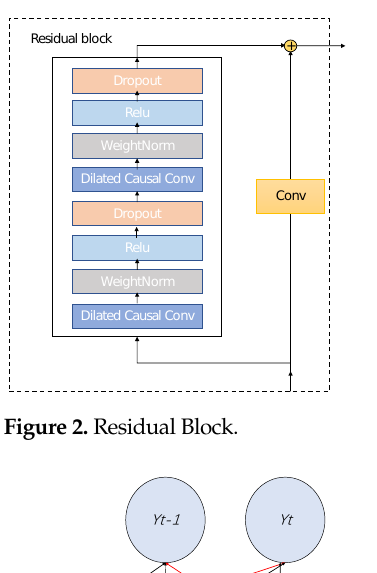
Figure 2. Residual Block.